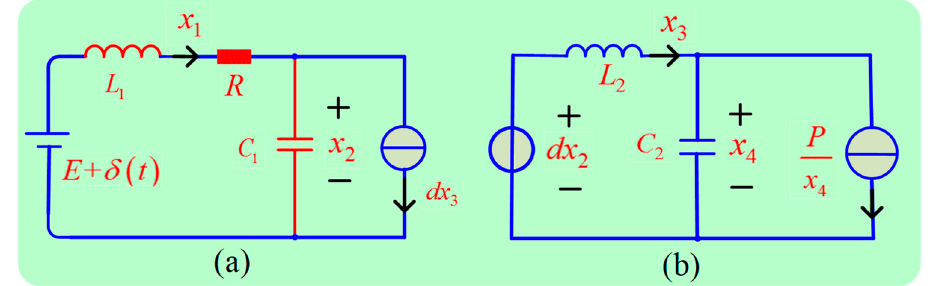
Figure 4. An equivalent average model of the DC microgrid with the proposed active damper.